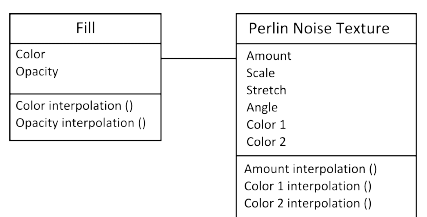
Figure 6: SLD extension for Perlin noise Texture description